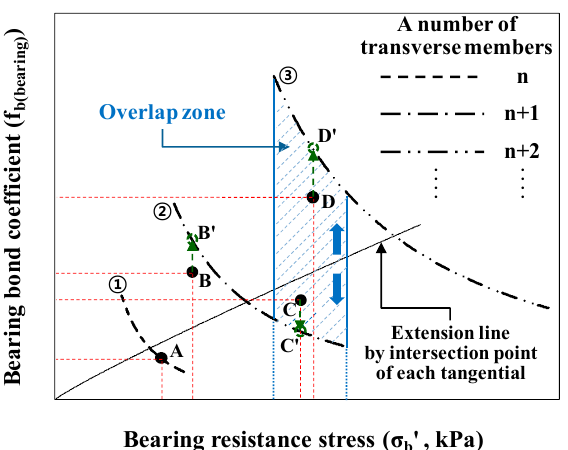
Figure 10. Prediction method for number of transverse members.